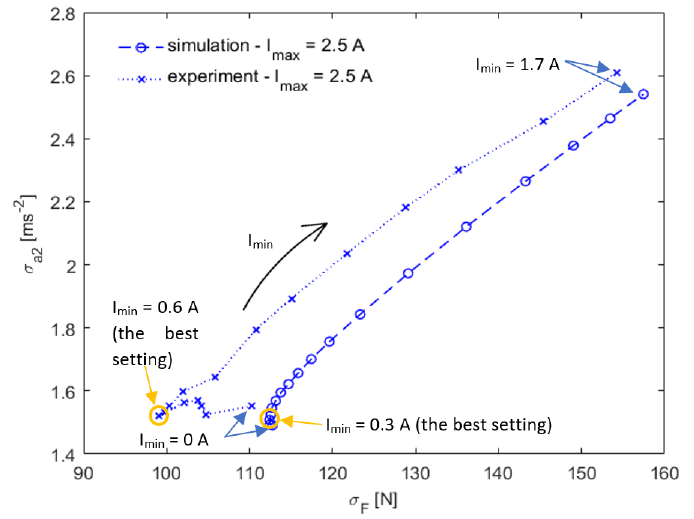
Figure 8. Groundhook setting—non-activated state setting I min (circled items indicate best setting according to the RMS of the adhesion force).